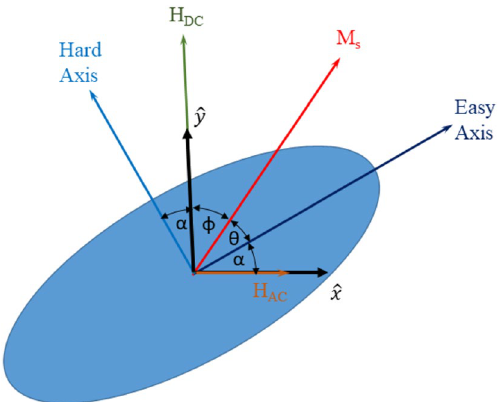
Figure 1. Geometry for the simulation of the SW-model and calculation of the transverse